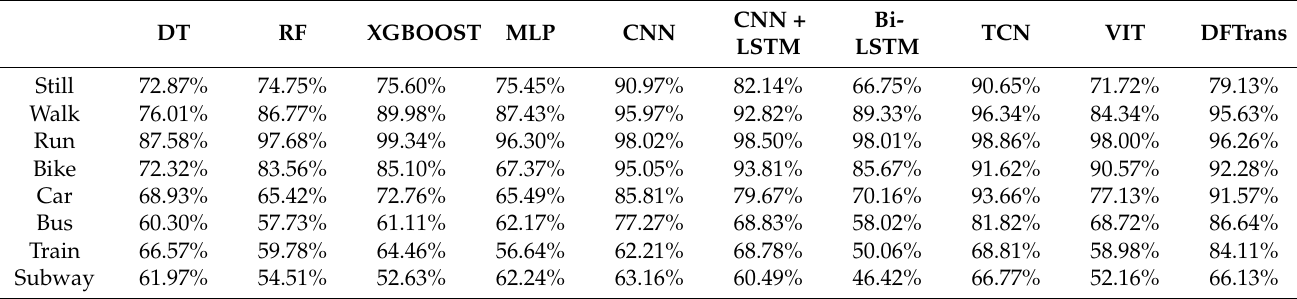
Table 4. Precisions of different algorithms on the SHL dataset.